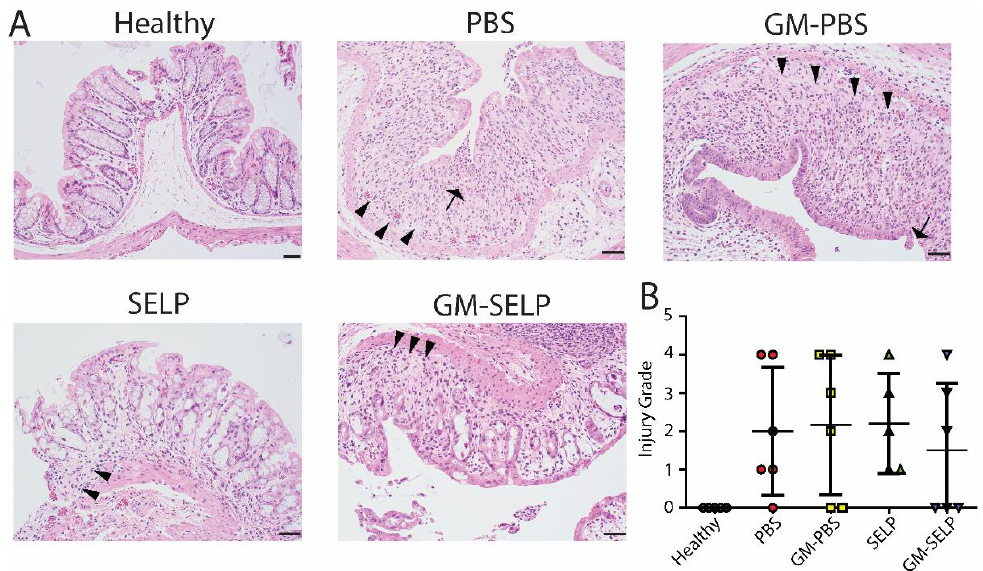
Figure 5. Time of sacrifice histological evaluation of rectal tissues. ( A ) Histological sections of healthy and irradiated animals receiving selected treatments. Arrows indicate epithelial erosion and arrowheads indicate crypt dropout. ( B ) Blinded scoring of histological sections to determine injury scores.